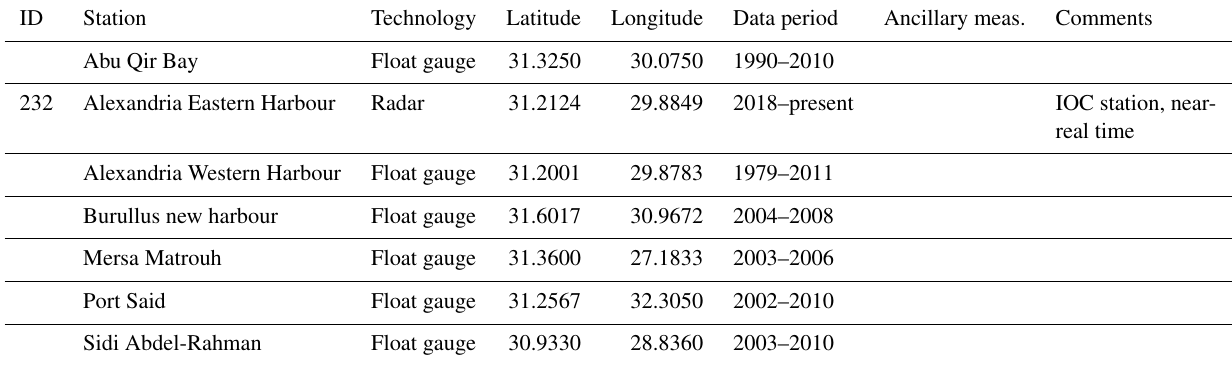
Table A25. Stations operated by